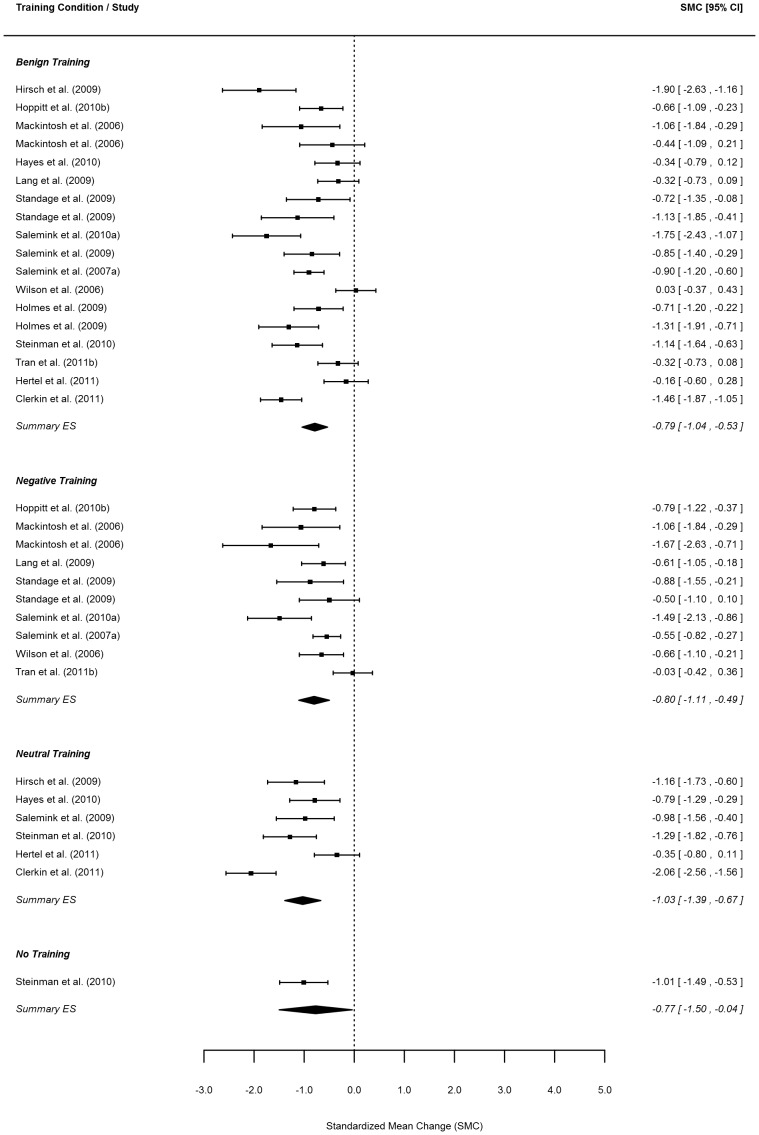
Forest plot of change in negative mood in response to an emotional challenge.
Note. Order of same conditions within one study follow the order of table 1. The summary effect size for the no-training condition is not identical to the effect size reported for the sole study in this condition as the model took multiple nesting (within study and within one article) into account and ‘corrected’ for such effects in the summary effect size.